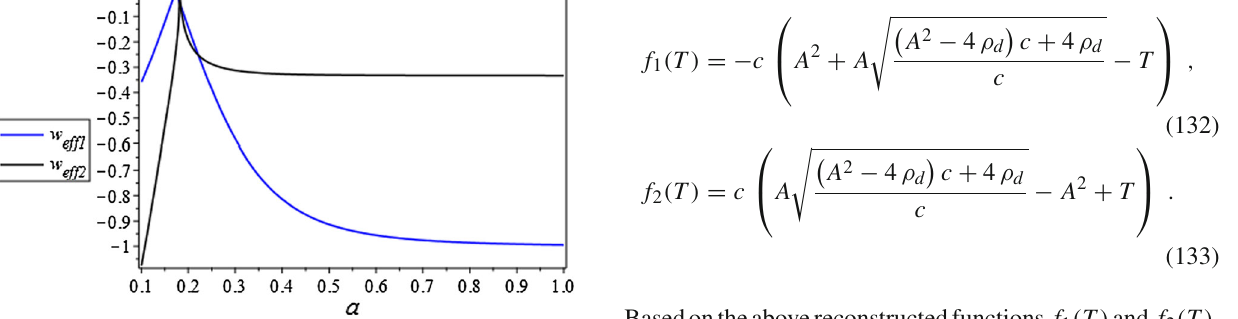
Fig. 7 w ef f ( 1 , 2 ) versus a for radiation-torsion system for GCG. We use c = 2 . 5 and A = 1 for all numerical